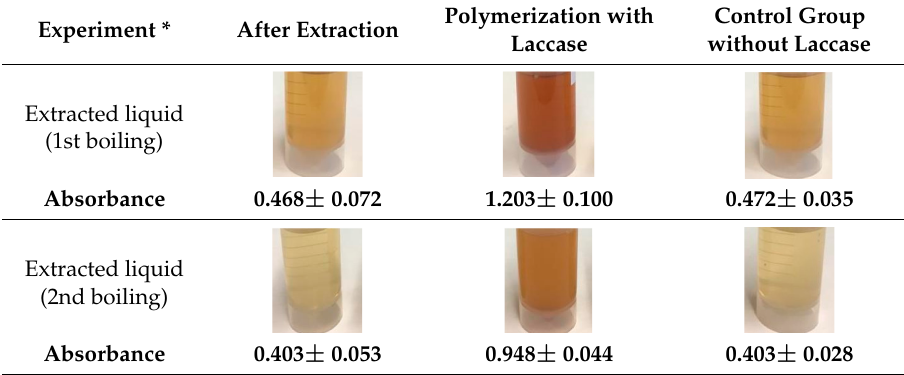
Table 3. The absorbance ( λ = 270 nm) after polymerization of the liquid extracts. Experiment *